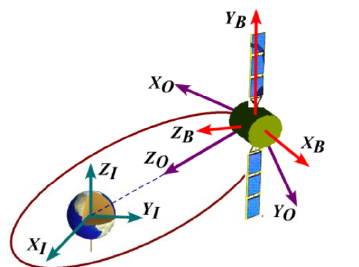
Figure 1. Coordinate reference frames